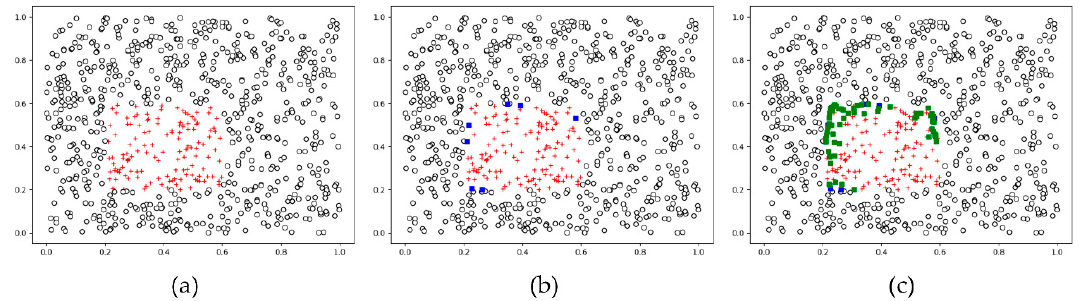
Figure 2. ( a ) An example of 2D binary class data with data imbalance: majority class of black circles and minority class of red crosses. ( b ) Among the minority class instances, a ‘DANGER’ set was made by selecting those instances whose neighbors are more included in the majority class than in the minority class—borderline minority instances, marked by blue squares. The number of neighbors, K = 5. ( c ) K new synthetic instances are created for each instance in the DANGER set (see the text for more details of the synthesis procedure); newly synthesized instances in the minority class are marked by green squares.